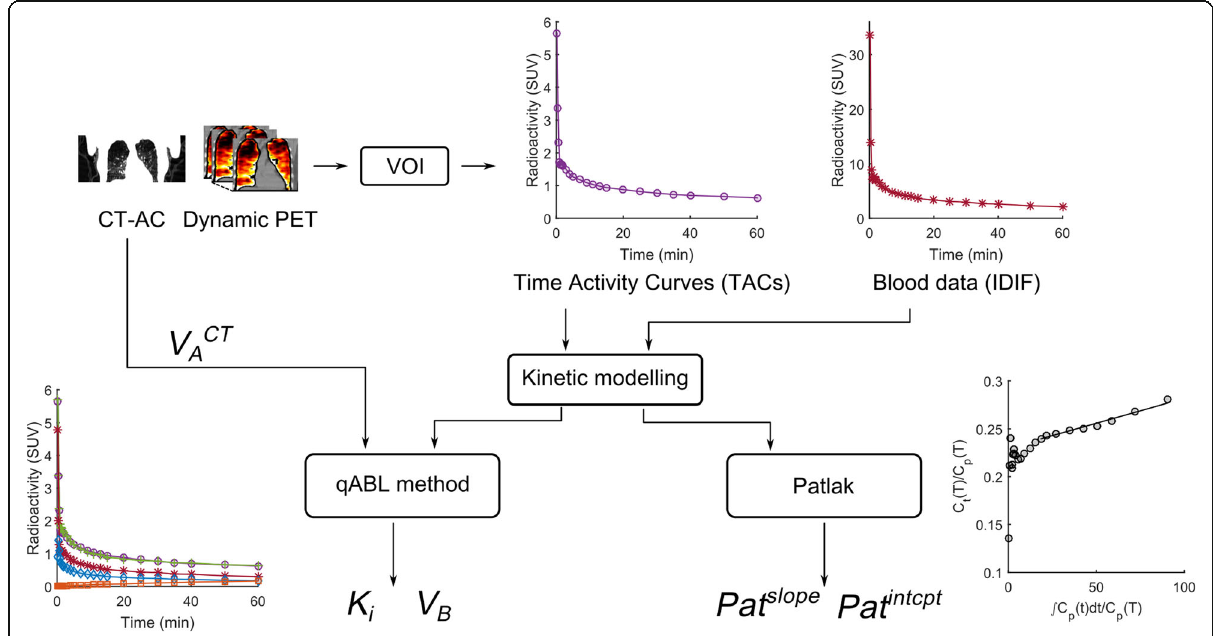
Fig. 1 Overview of the kinetic modelling approaches implemented in this paper to analyse dynamic 18 F-FDG lung PET